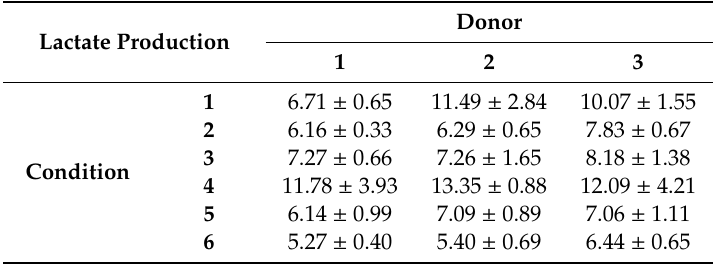
Table 4. The accumulated lactate divided by the cell numbers at the end of the cell culture period and divided by total culture time (120 h), averaged over the triplicates for each donor and condition (10,000,000 mM cell − 1 h − 1 ).